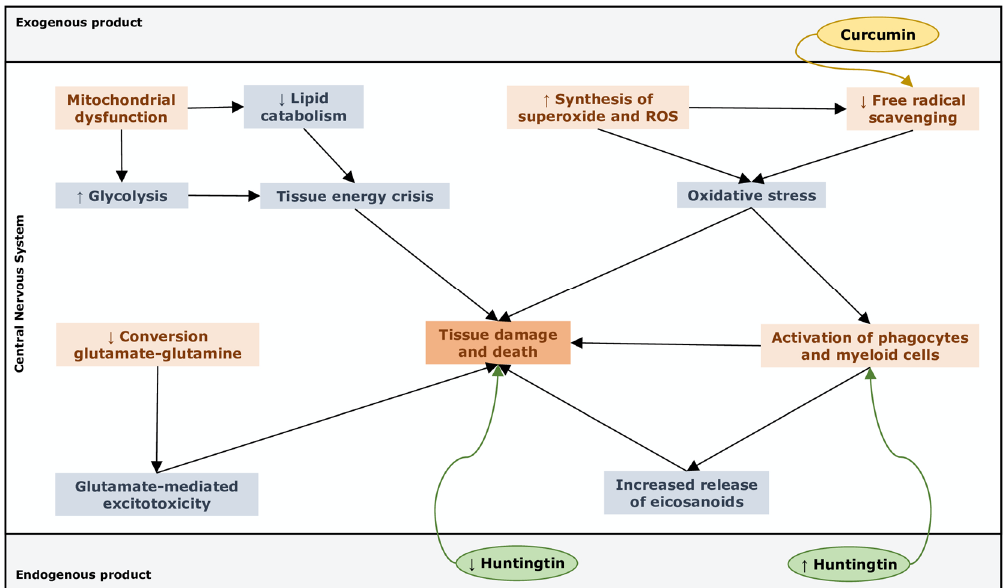
Figure 1. Orange boxes indicate pathophysiological triggers of tissue damage. Light cyan boxes describe metabolic path- ways, in which metabolites from the dataset are involved. These metabolic pathways are involved in MS pathophysiology through alteration of biological functions such as small molecule biochemistry, controls of cell death, metabolic disease and cell to cell signalling. Dark orange boxes represent the endpoint of the metabolic cascades that lead to tissue damage and death. Upstream regulators, i.e., molecular regulator of metabolite expression, as identified by our pathway analysis, can promote tissue damage and death directly or through an activation of the immune system. These regulators and their effects are indicated in green (for huntingtin, an endogenous product) and in yellow (for curcumin, an exogenous product).